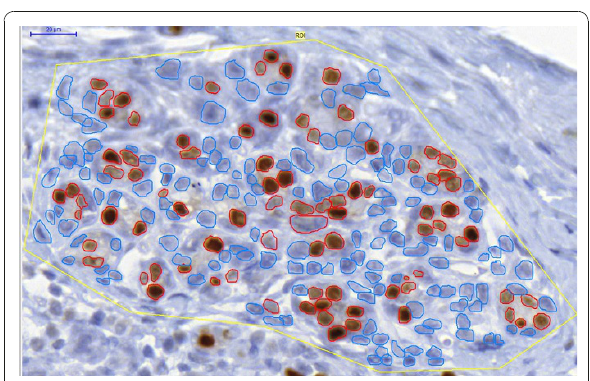
Figure 1 Manual marking of cells within a ROI . Blue = negative cells, Red = positive